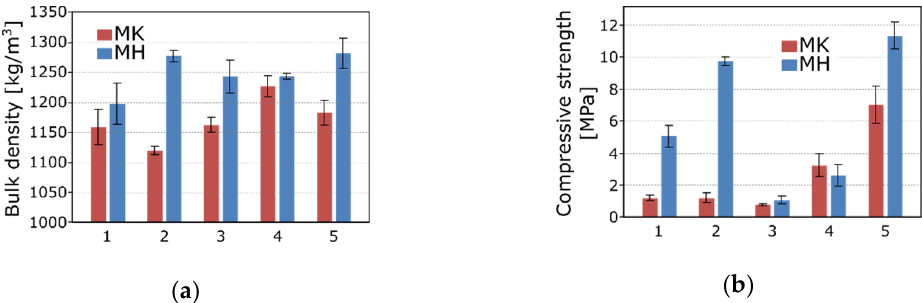
Figure 7. The physical and mechanical properties of the obtained samples: ( a ) bulk density; ( b ) compressive strength.